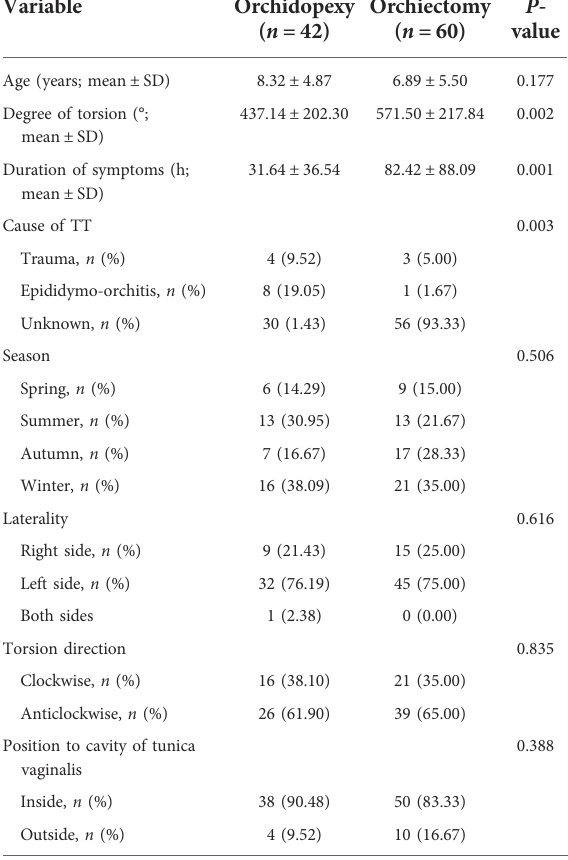
TABLE 3 Comparison between patients underwent orchidopexy and orchiectomy.